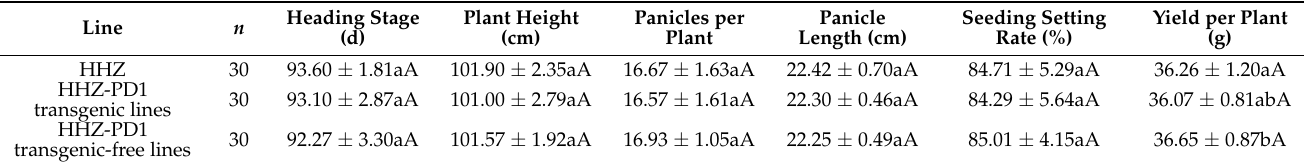
Table 5. Main agronomic traits of HHZ-PD1 in T 2